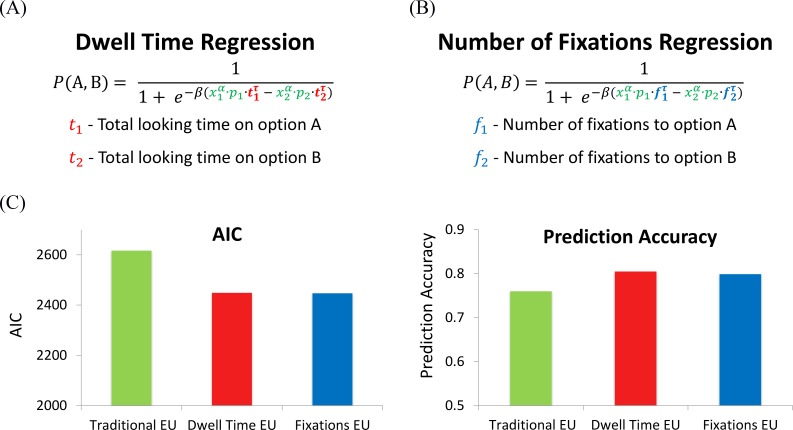
Expected Utility based regression models.(A) EUDwell-time: the EU value of each of the alternatives is modulated by the total looking time on each alternative. (B) EUFixations: the EU value of each of the alternatives is modulated by the relative number of fixations towards it. (C) Prediction accuracy and AIC for the traditional, dwell time and number of fixations EU.